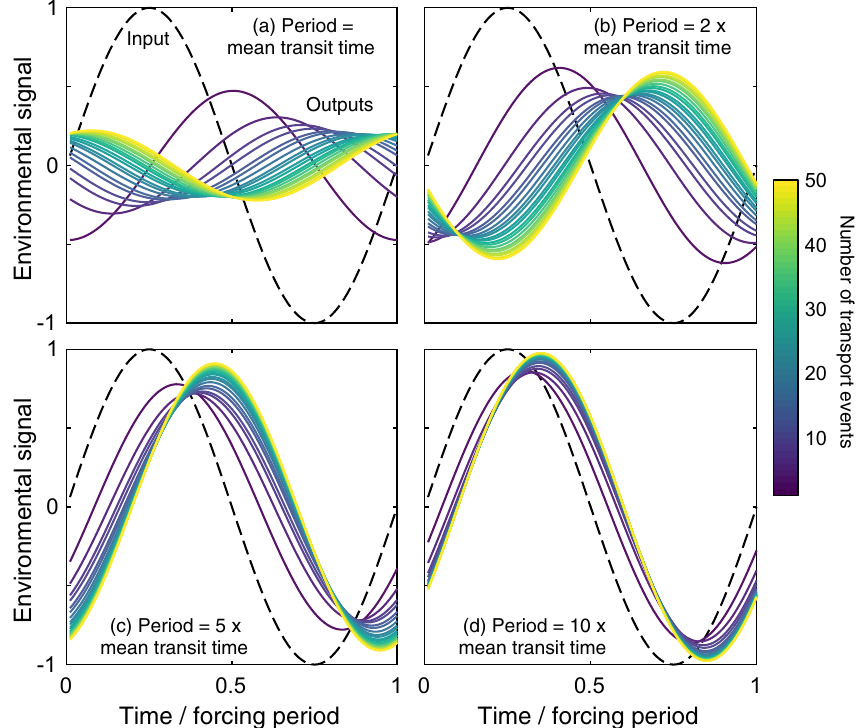
Figure 6. Effect of floodplain storage on environmental signals recorded by organic biomarkers. This figure shows the effect of convolving our sediment transit time distributions with a sine wave where the period of the sinusoidal input is equal to the mean transit time (a) , twice the mean transit time (b) , 5 times the mean transit time (c) , and 10 times the mean transit time (d) . The amplitude and phase of the sinusoidal input is shown as the black dashed lines. The colored lines refer to the output signal with the color reflecting the number of transport events (see color bar), which sets the shape of the transit time distribution. The model results suggest that climate signals recorded in terrestrial biomarkers will be significantly modulated if their period is short relative to the mean sediment transit